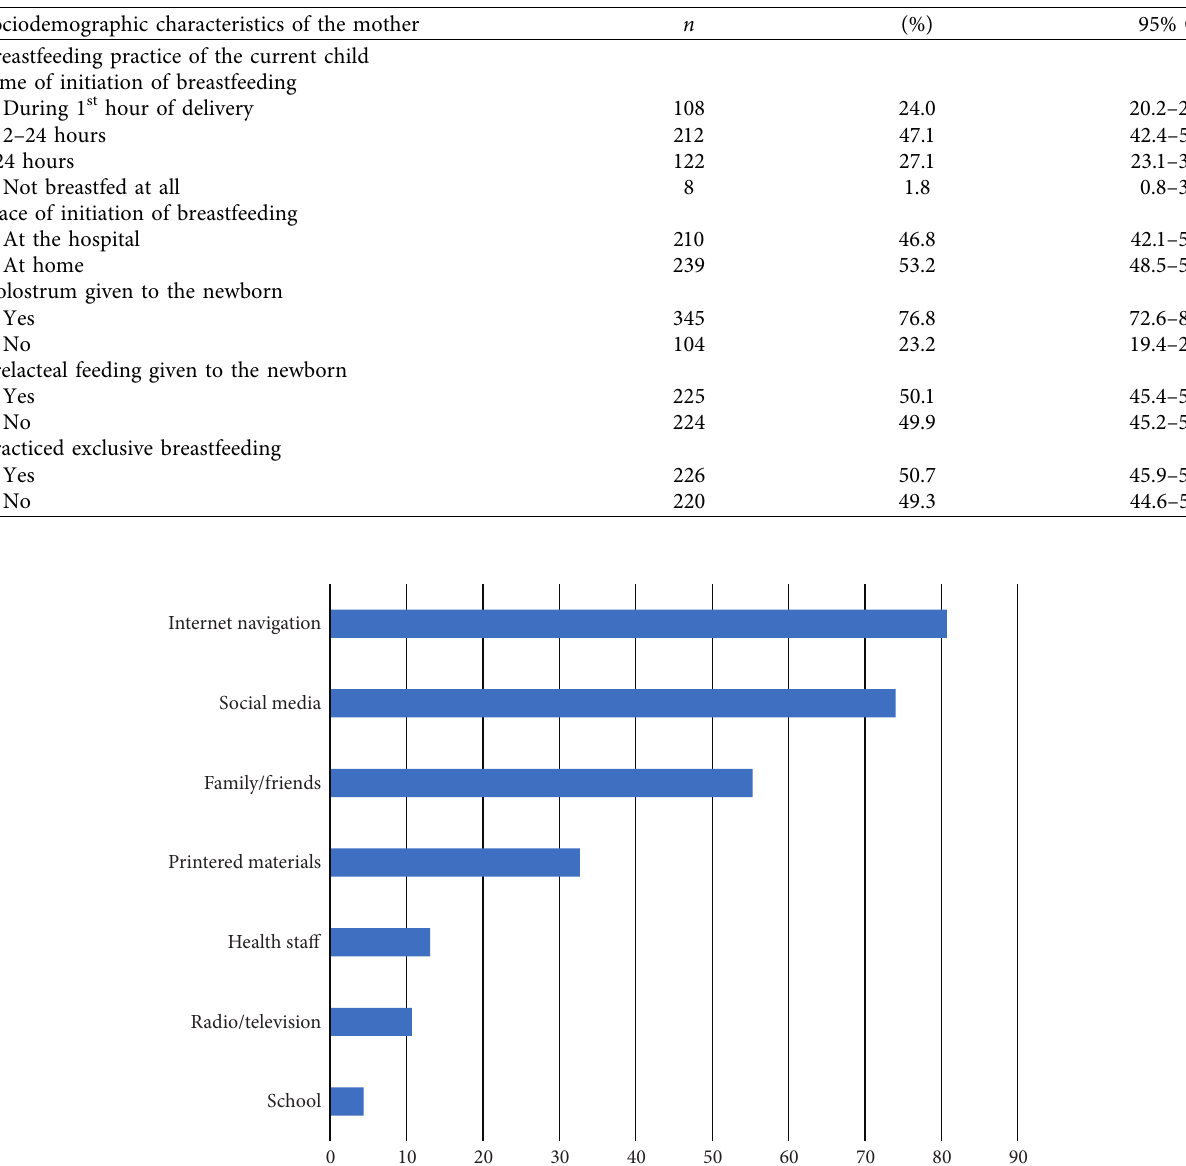
Figure 1: Frequency of use (%) of different sources of knowledge about breastfeeding among participants. Participants may report more than one source of